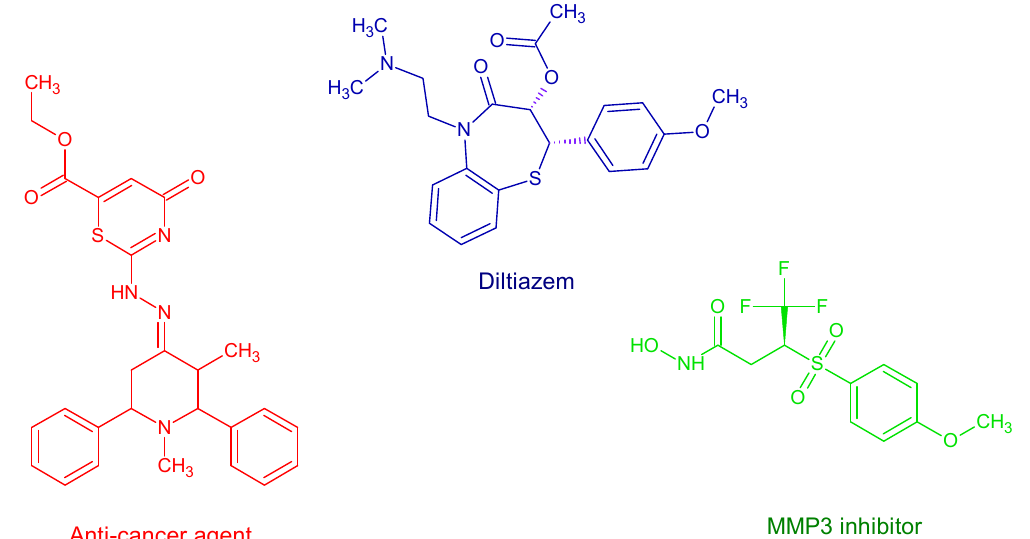
Figure 2, MMP3 inhibitors (matrix metalloproteinase ‐ 13 involved in the breakdown of collagen II), and antihypertensive drugs (Diltiazem, a drug which is also used to treat angina as well as decrease high blood pressure) (Figure 2) [3].